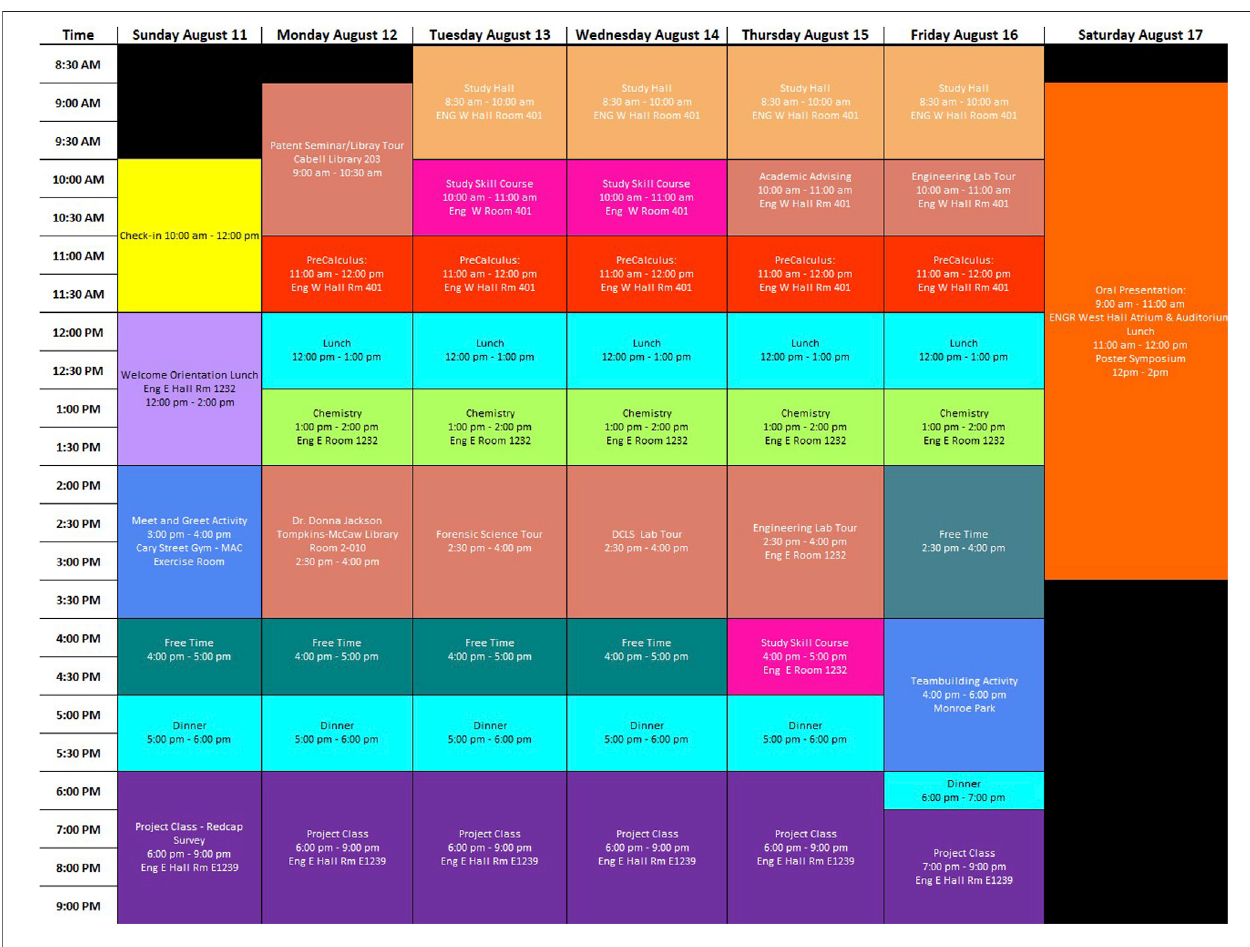
FIGURE 2 | VCU-LSAMP Sample Orientation Week